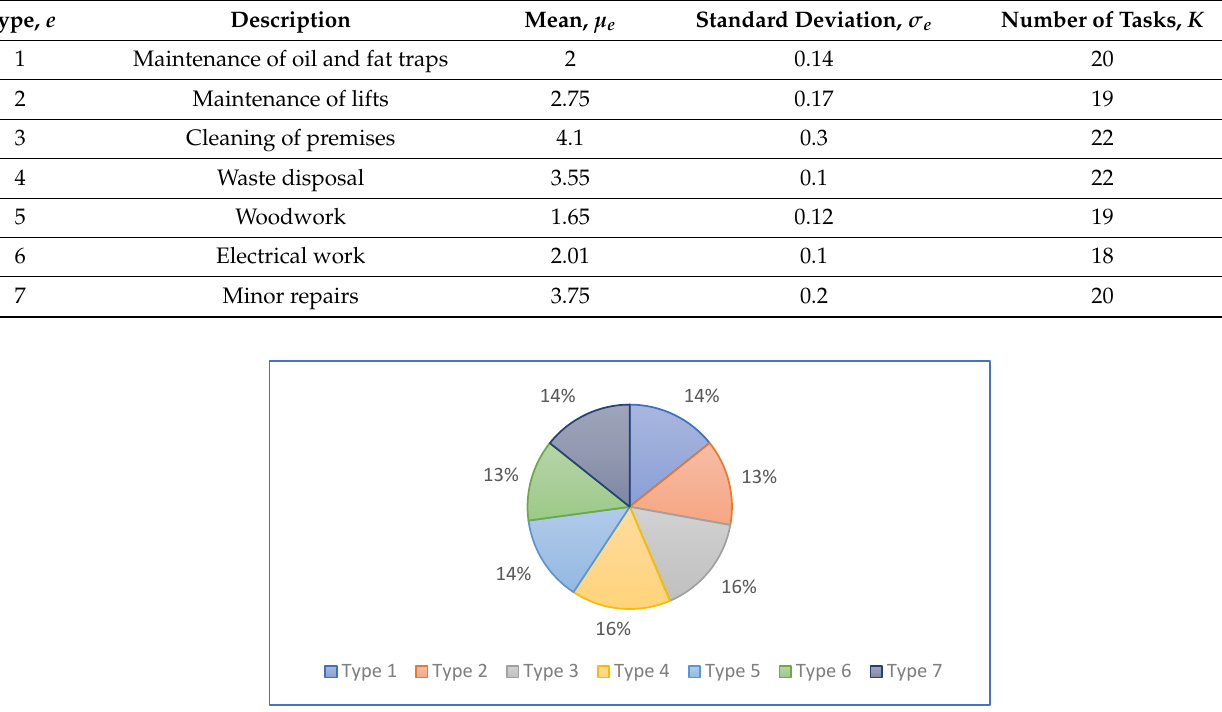
Figure 8. Distribution of task types. Table 5. The generated standard durations and types for each task.